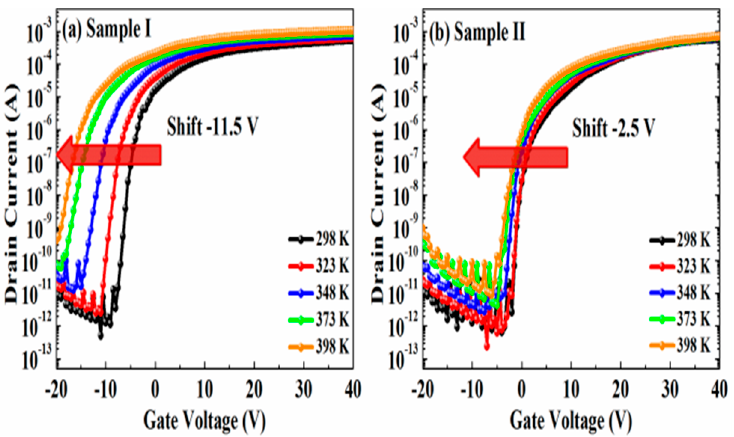
Figure 6. Thermal stress of the N-doped DSCL TFTs: ( a ) a-IGZO:N/a-IZO:N TFT (Sample I); ( b ) a-IZO:N/a-IGZO:N TFT (Sample II). The transfer curves were obtained with V DS = 10 V.